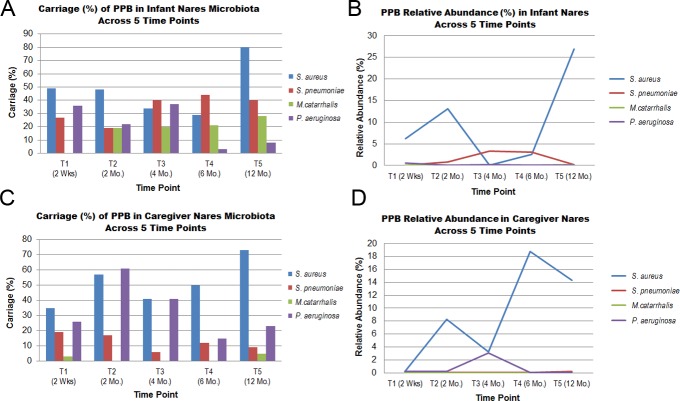
Relative abundance (A, B) and carriage (C, D) of potentially pathogenic bacteria (PPB) in the nares of infants and their primary caregivers over the first year of life. Relative abundance depicted represents the average values derived from each subject grouping at each sampling time point T1-T5 (range: 22–35 subjects per time point, in a possible maximum of (n = 40) study subject pairs). Carriage depicted represents the percentage of individuals carrying the organism at each time point.